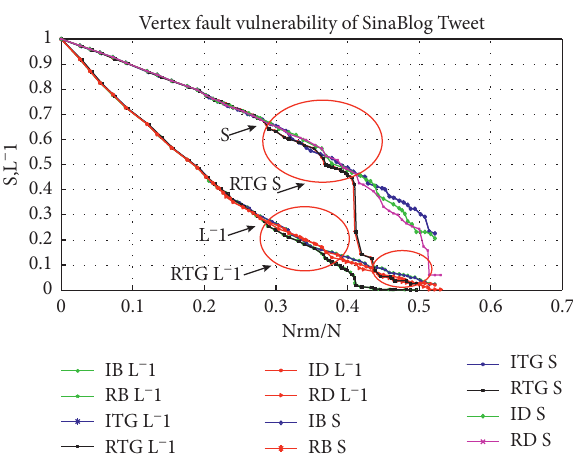
Figure 16: C G �( V,E ) result of Calling Record.